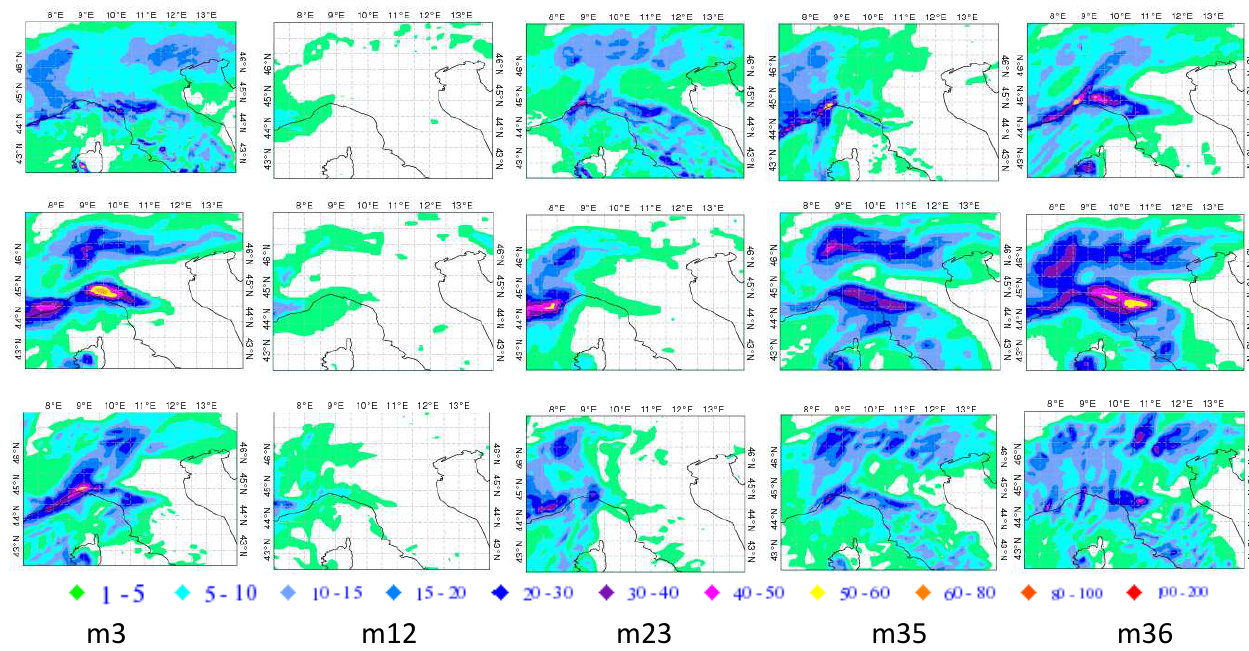
Fig. 8. 6h accumulated precipitation (mm) at 00:00UTC, 30 November 2008 forecast by the different members of the multi-model ensemble at long-range ( + 84h; see text). Five forecasts for each model: COSMO (top), BOLAM (middle) and WRF (bottom). Models are initialized at 12:00UTC, 26 November 2008. The driving global representative member (m) is indicated below each panel column.